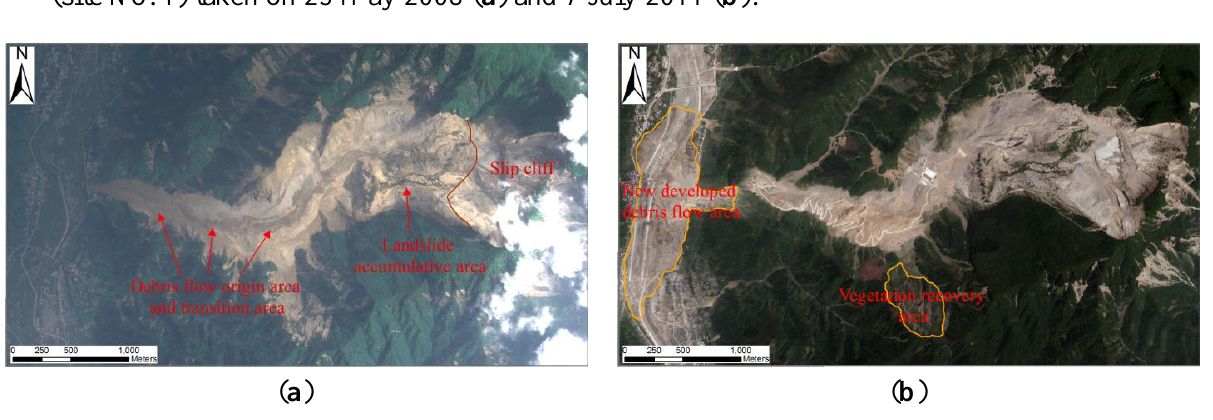
Figure 2. Airborne remote sensing images of Wenjiagou, Qingping Town, Mianzhu City (site No. 1) taken on 23 May 2008 ( a ) and 7 July 2011 ( b